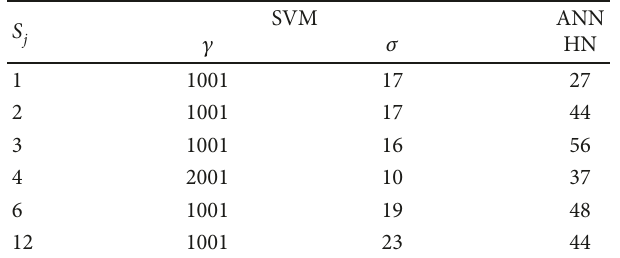
Table 3: Parameters for the manufacturing system.